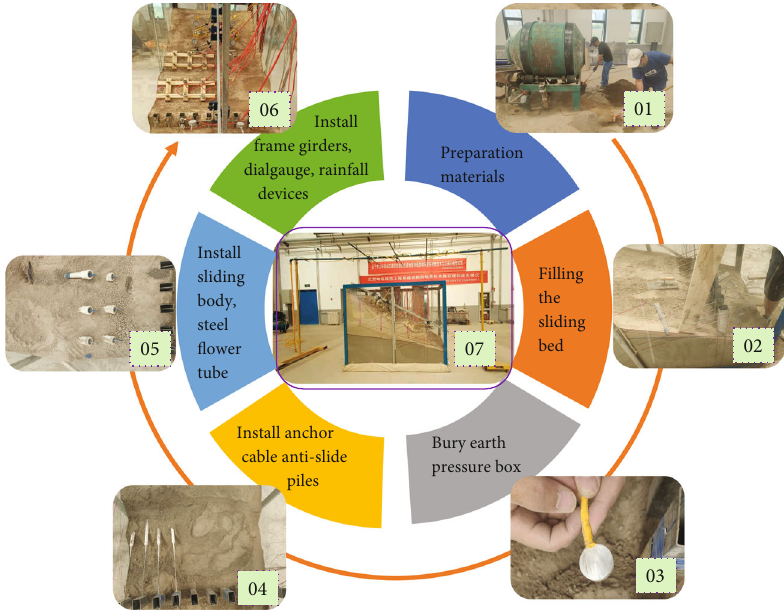
Figure 4: Model fi lling